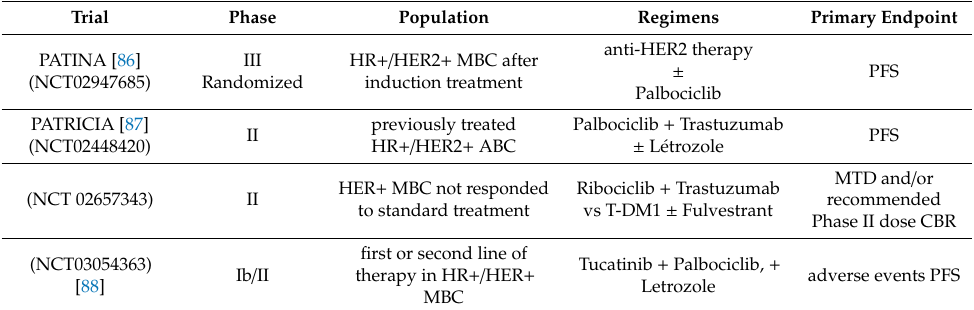
Table 5. Ongoing clinical trials assessing cell cycle inhibitors combined with anti-HER drugs in triple positive